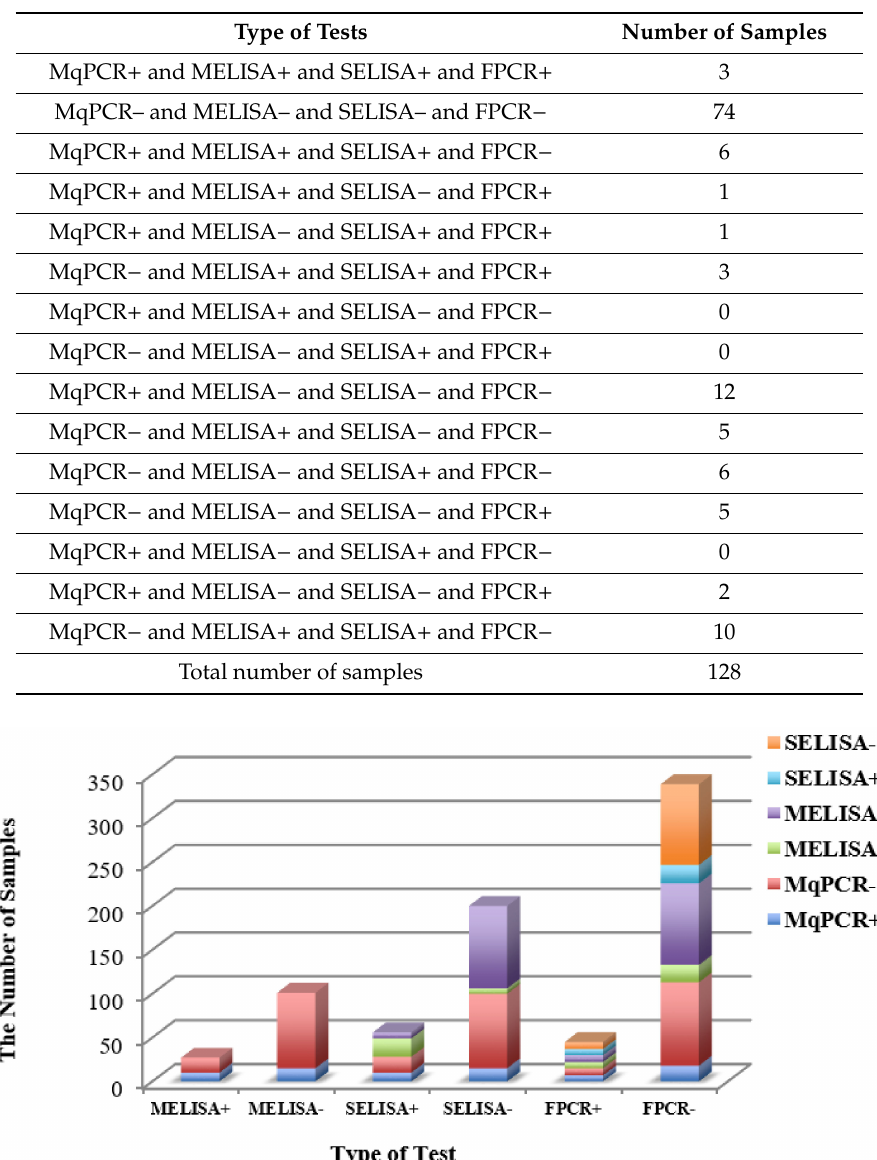
Table 6. Distribution of 128 MIF milk samples in fifteen quaternary groups based on positive / negative status in MqPCR, MELISA, SELISA, and FPCR tests.